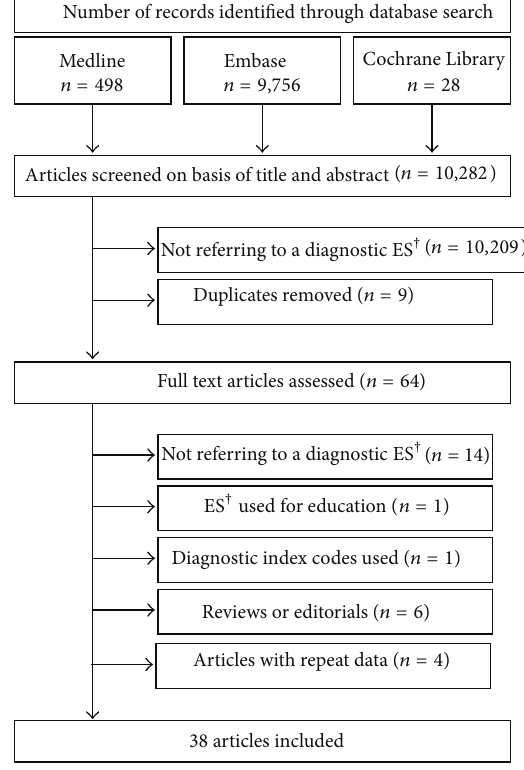
Figure 3: Selection of